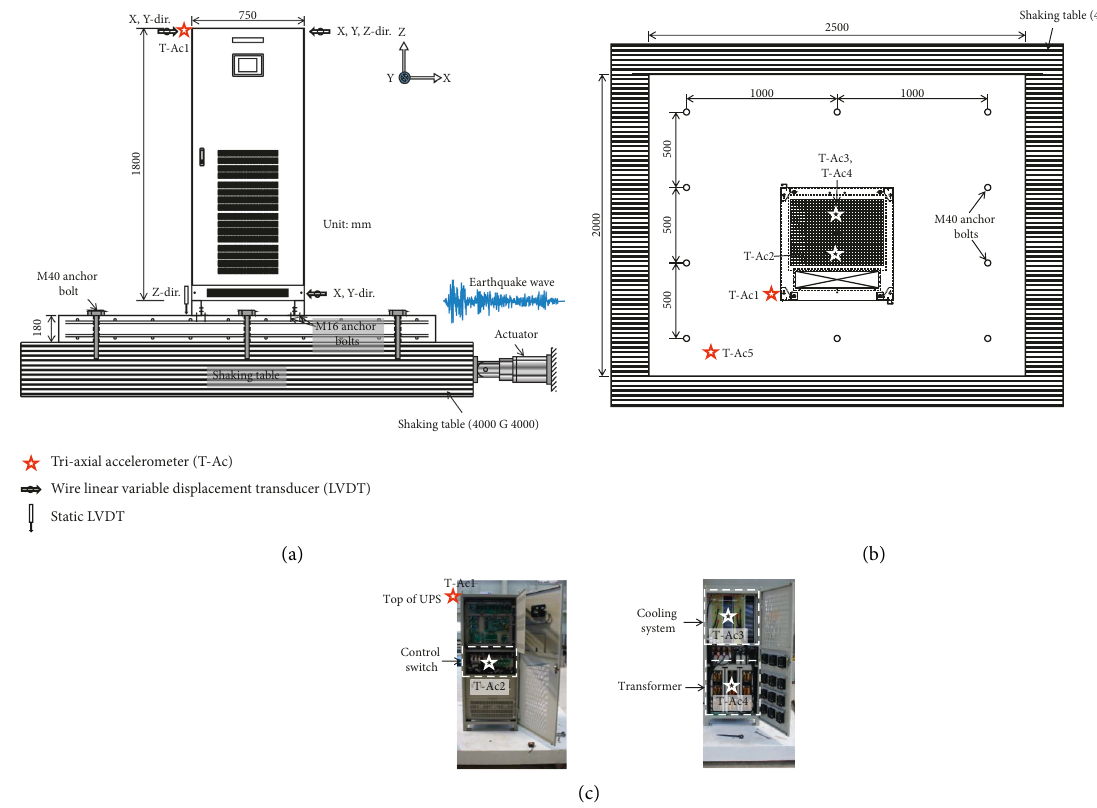
Figure 5: Shaking table test setup and measurement instrumentation. (a) Front view. (b) Plan view. (c) Locations of triaxial accelerometers. Table 2: Detailed specifications of the shaking table test.